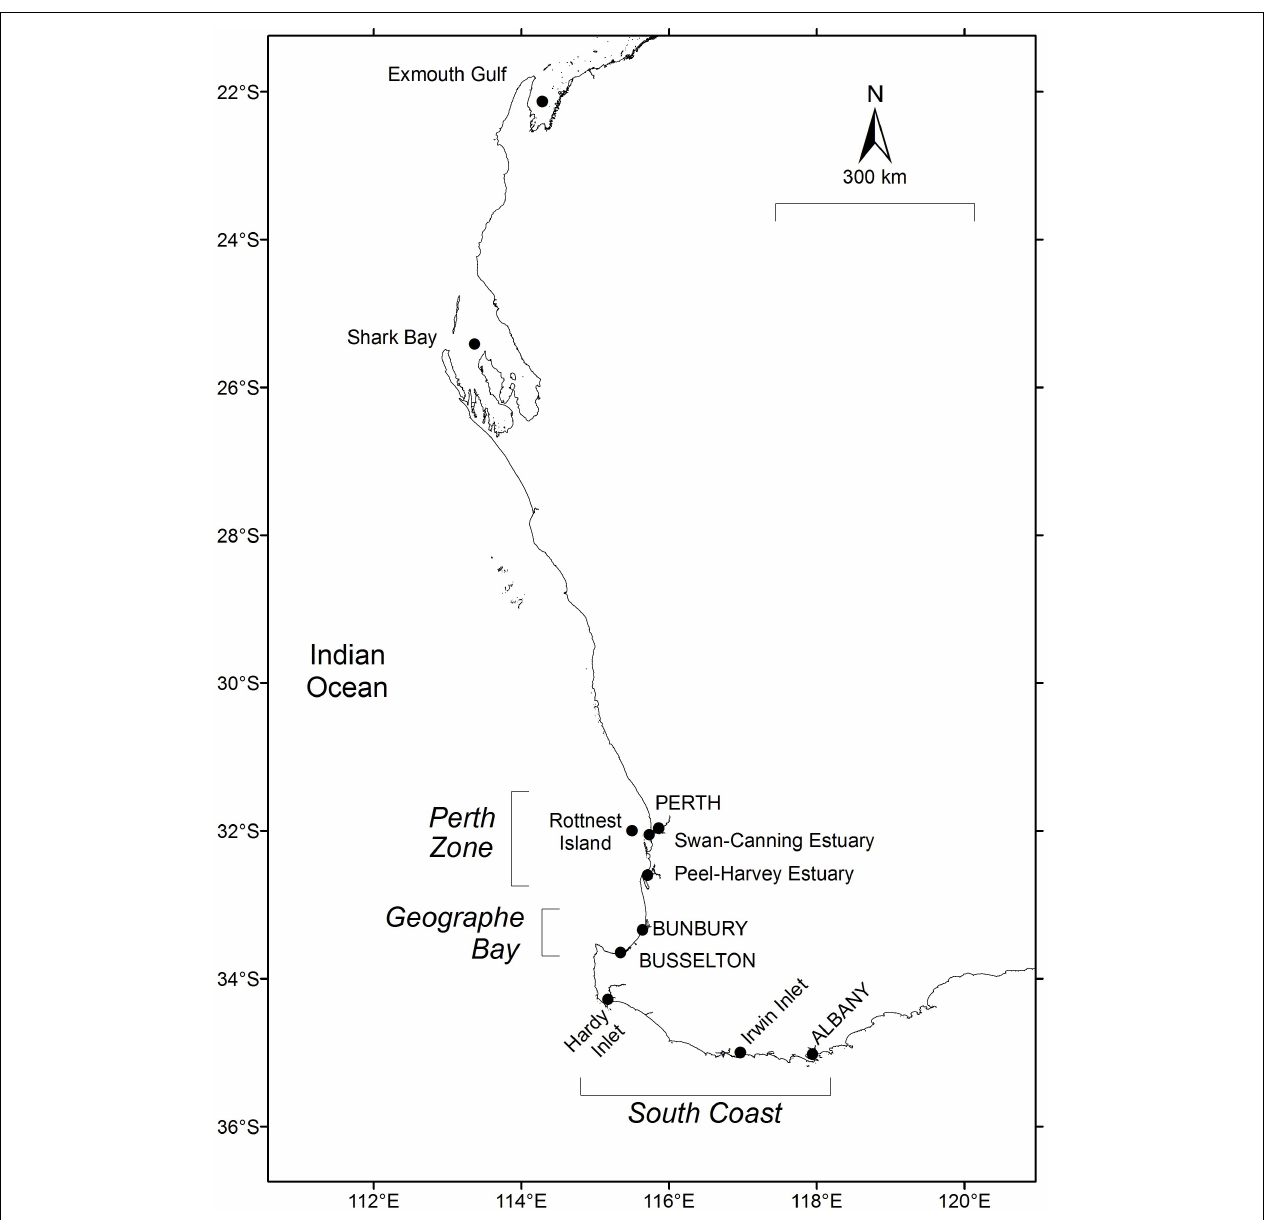
FIGURE 1 | Location of fisheries and sampling locations for Sillago schomburgkii in Western Australia.